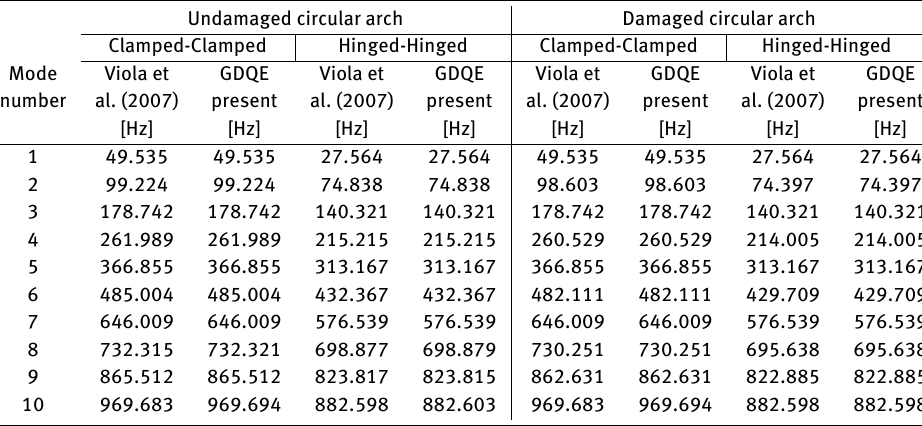
Table 3: Comparison between the analytical solution and the current in-house code values for the first 10 natural frequencies of an undam- aged and a damaged three-stepped circular arch.